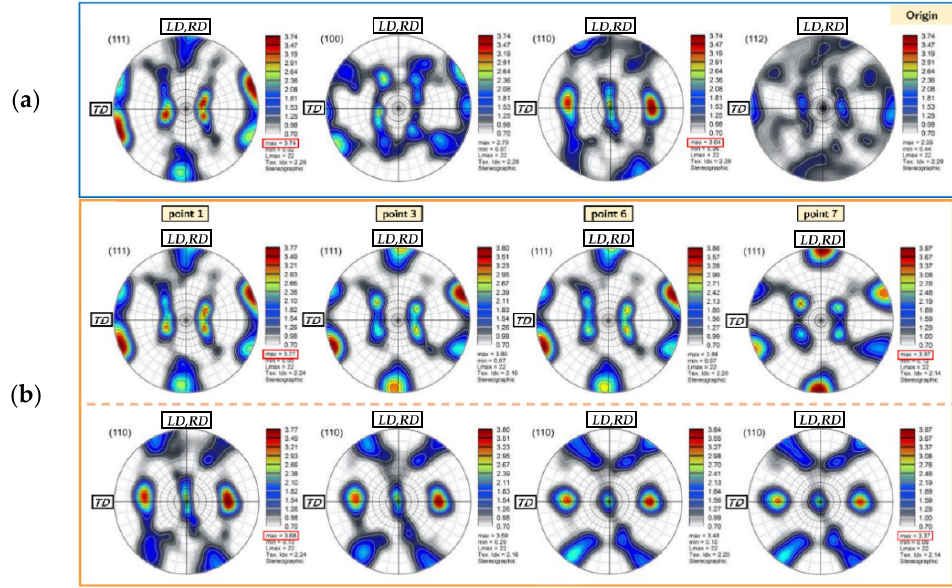
Figure 3. The pole figures of the 316 steel before and after the plastic deformation. ( a ) The (111), (100), (110), (112) pole figures of the original 316 steel; ( b ) The (111) and (110) pole figures of the 316 steel at the different plastic